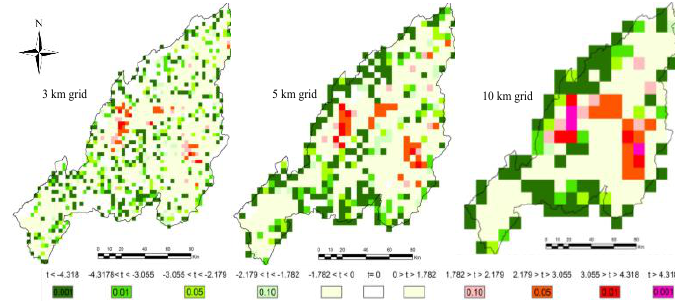
Fig. 4. Regression slopes in fire incidencesat different grid sizes (a) 3 km, (b) 5 km, (c) 10 km. Color significance of trend regression slopes based on two-tailed student’s t distribution for changes in fire incidences over